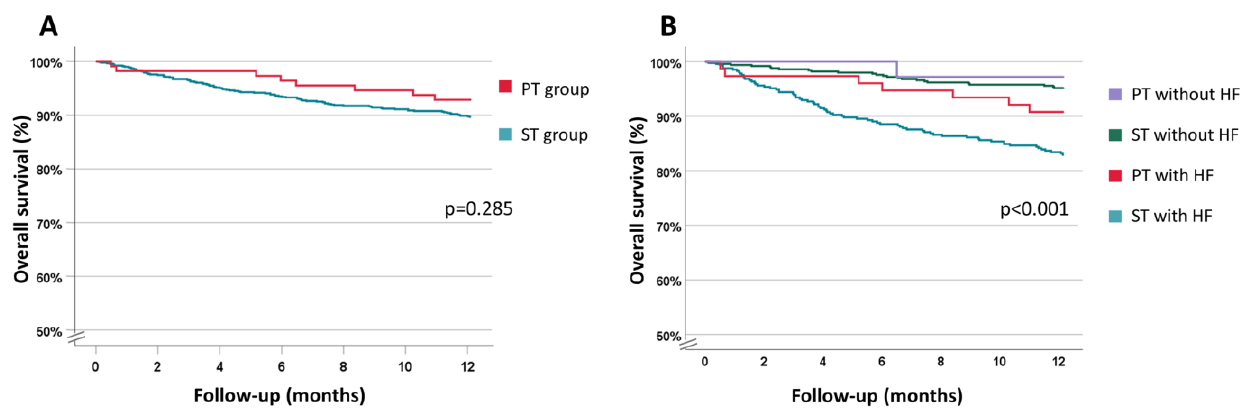
Figure 1. Kaplan–Meier curve. ( A ) Overall survival in the ST vs. PT groups. ( B ) Overall survival in the ST and PT groups stratified according to the presence of HF. PT (patient-specific therapy), ST (standard therapy).